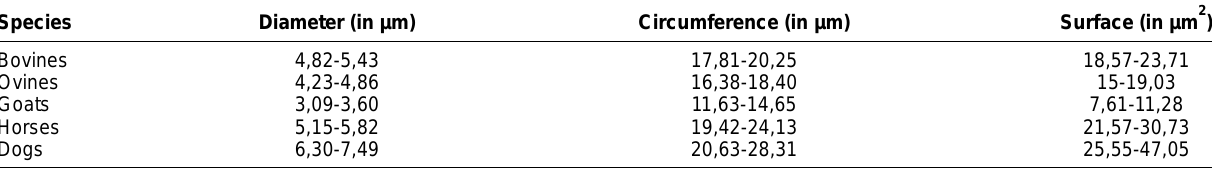
Figure-3. Influence of red blood cells surface on the determinism of the species of pets. Table-4. Overview of morphometric parameters of pets red blood